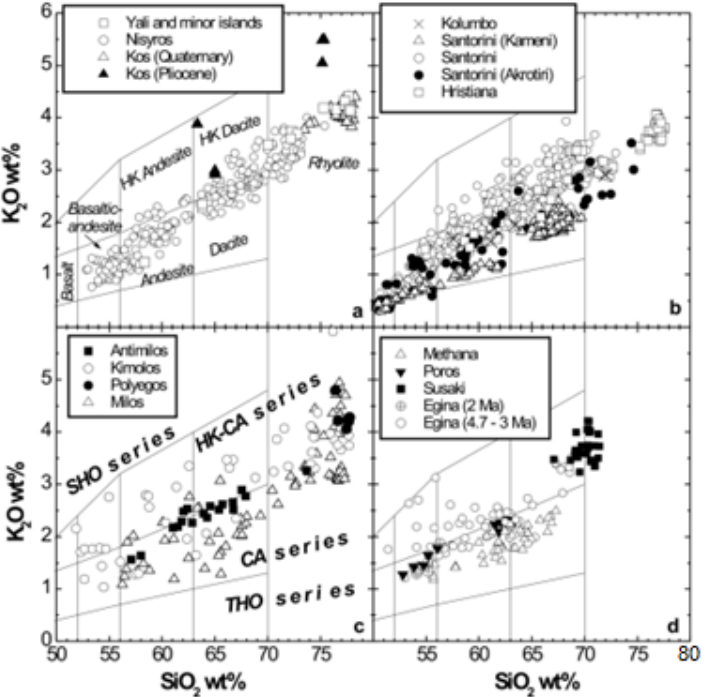
Figure 2. K 2 O versus silica classification diagrams [4] for ( a ) Nisyros group ( b ) Santorini group ( c ) Melos group and ( d ) Methana group.